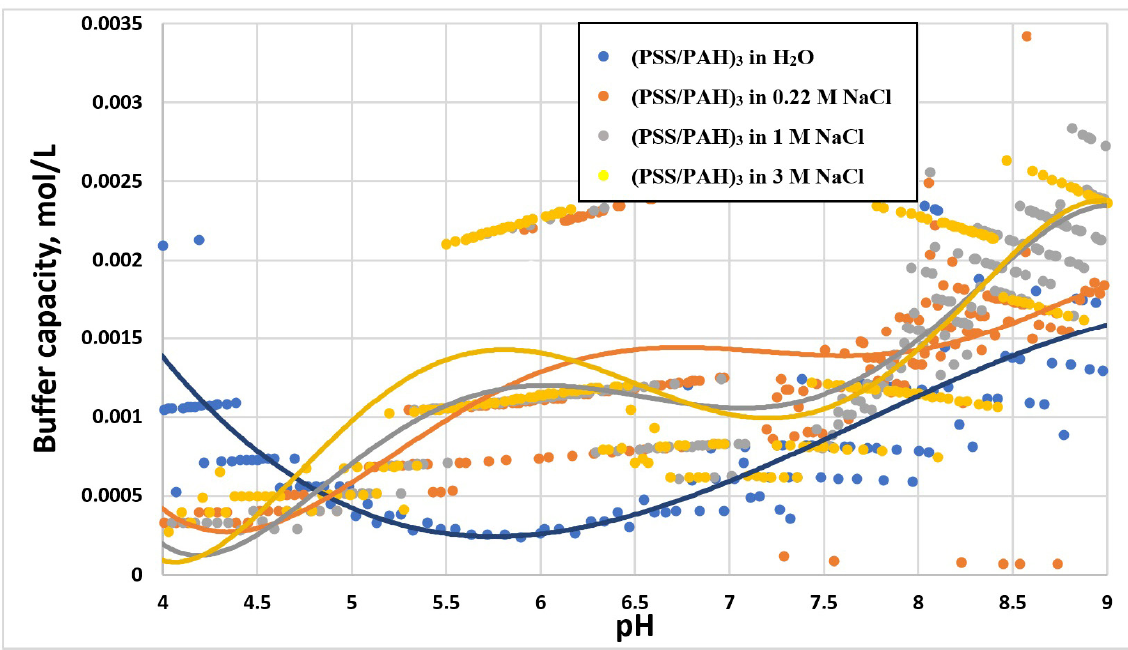
Figure 2. Buffer capacity of PMC composition (PSS/PAH) 3 at different pH in water, 0.22 M, 1 M and 3 M NaCl